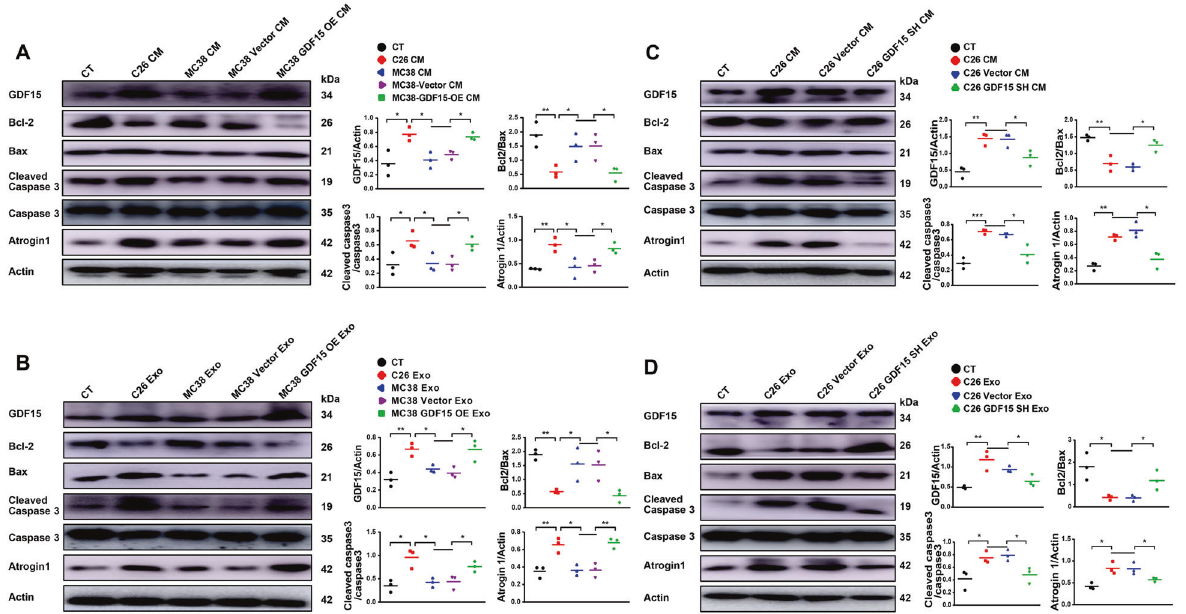
Fig. 7 Con fi rmation of the involvement of apoptotic pathway in GDF15-induced muscle atrophy. C2C12 myotubes were treated with MC38-GDF15-OE cell medium, exosomes or C26-GDF15-SH cell medium, exosomes respectively. A Analysis of the protein level of MHC, GDF15, Bcl-2, Bax, Cleaved caspase-3, Atrogin1 in C2C12 myotubes treated with MC38-GDF15-OE cell medium ( n = 3, * p < 0.05, ** p < 0.01; t test). B Analysis of the protein level of MHC, GDF15, Bcl-2, Bax, Cleaved caspase-3, Atrogin1 in C2C12 myotubes treated with MC38-GDF15-OE cells derived exosomes ( n = 3, * p < 0.05, ** p < 0.01; t test). C Analysis of the protein level of MHC, GDF15, Bcl-2, Bax, Cleaved caspase-3, Atrogin1 in C2C12 myotubes treated with C26-GDF15-SH cell medium ( n = 3, * p < 0.05, ** p < 0.01, *** p < 0.001; t test). D Analysis of the protein